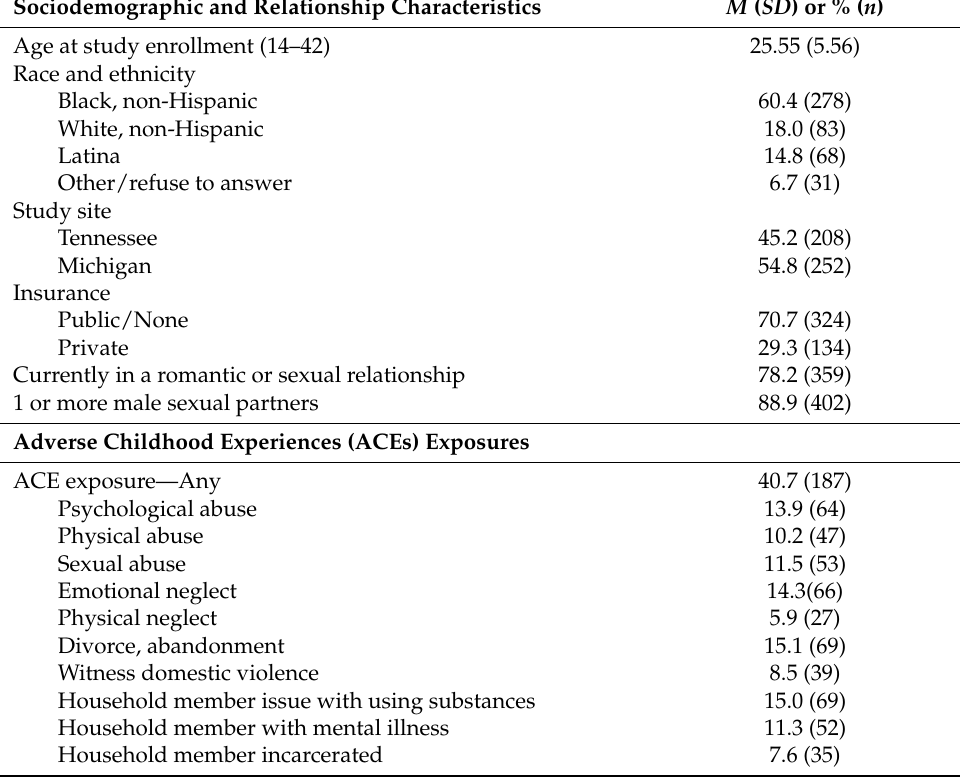
Table 1. Sample Characteristics: Demographics, Adverse Childhood Experiences and Sexual Risk ( n =